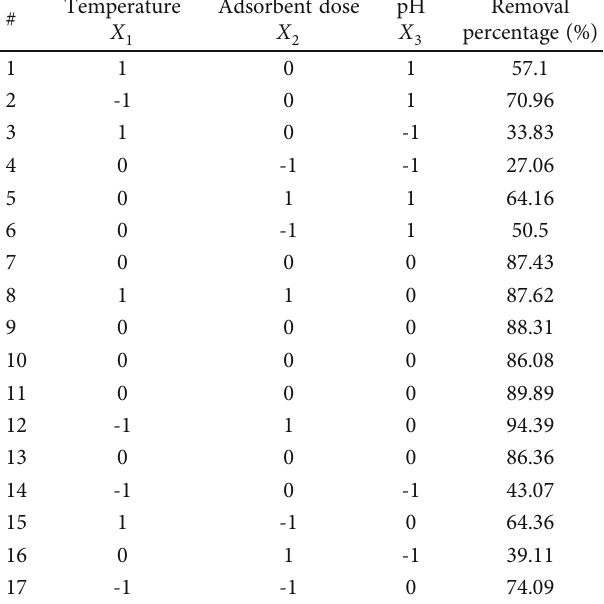
Table 3: Experimental design and its actual